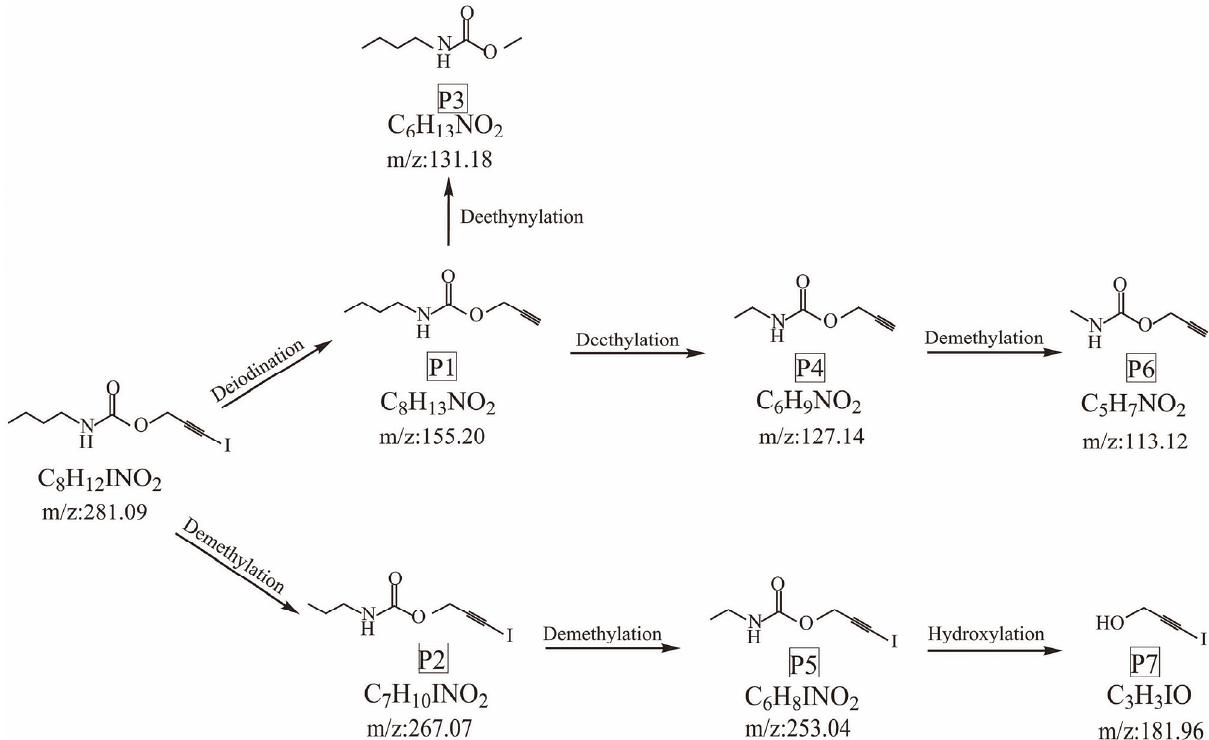
Figure 10. Two possible thermal degradation pathways of IPBC.